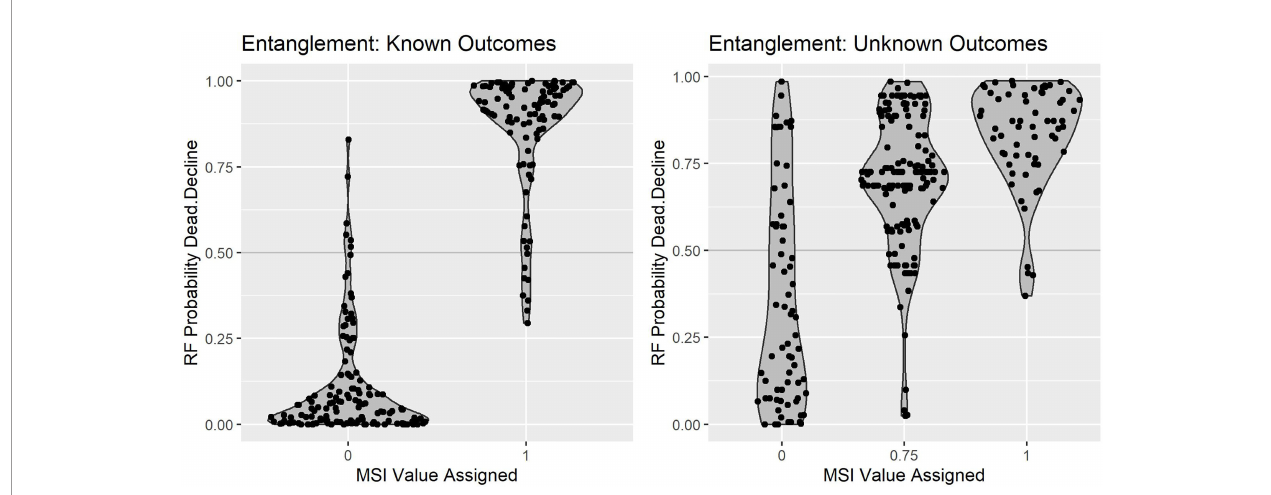
FIGURE 4 | RF predicted probabilities of ‘ Dead.Decline ’ vs MSI values assigned by scientists using current serious injury guidelines for entanglement cases of right and humpback whales, combined. Non-serious injuries are represented by MSI values = 0 and serious injuries are represented by all other values.